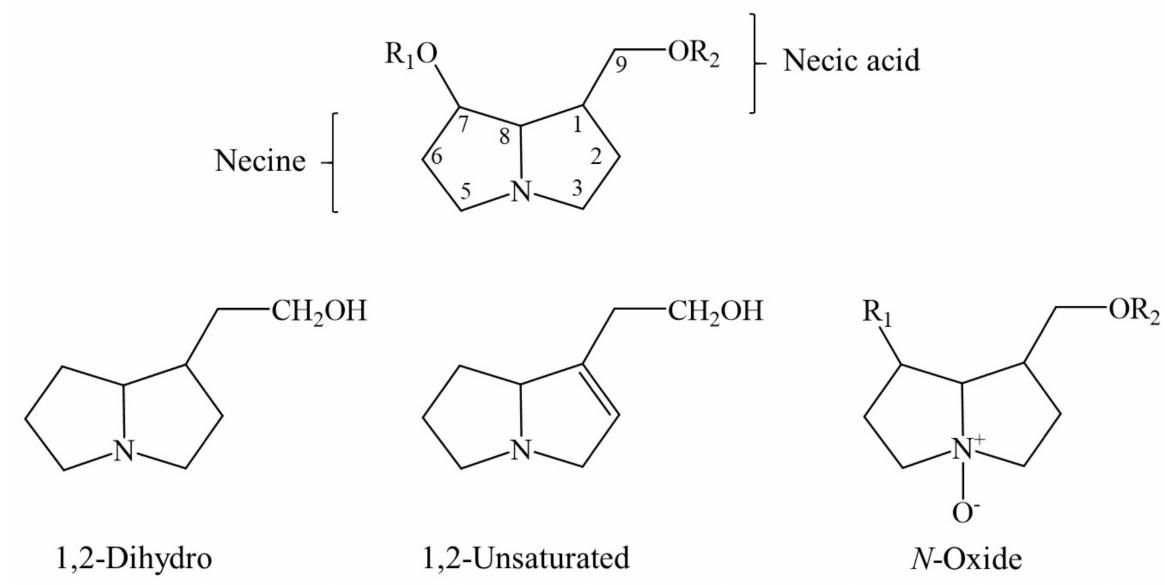
Figure 6. Structure of a PA and its different forms. R 1 and R 2 correspond to different necic acids. Abbreviation: PA, Pyrrolizidine alkaloid. The figure was obtained from the open access report of Moreira et al.